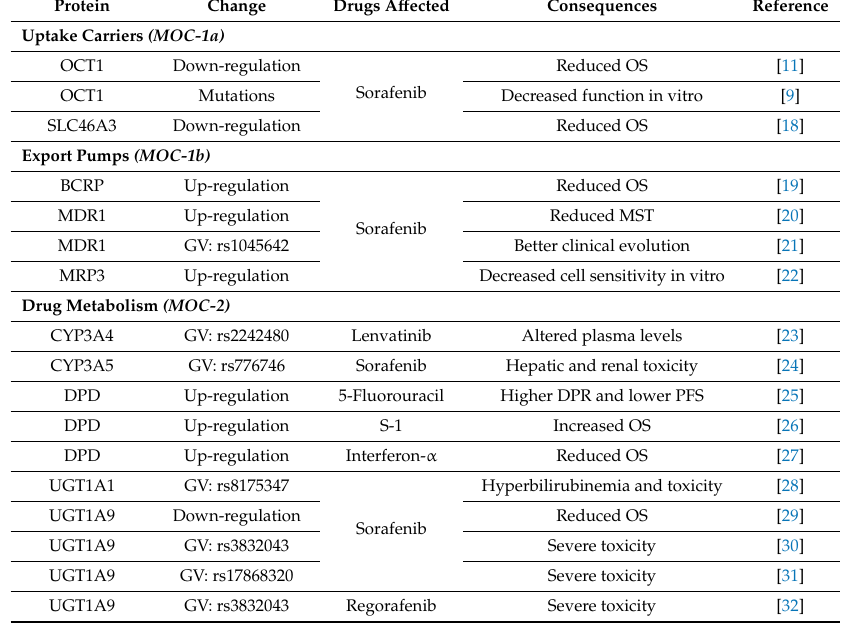
Table 1. Mechanisms of chemoresistance type 1 (MOC-1) and 2 (MOC-2) to drugs clinically used in HCC (hepatocellular